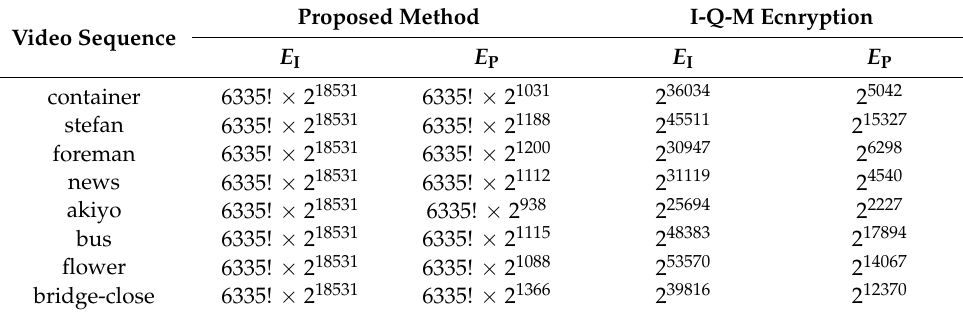
Table 3. The encryption space of I frame and P frame.